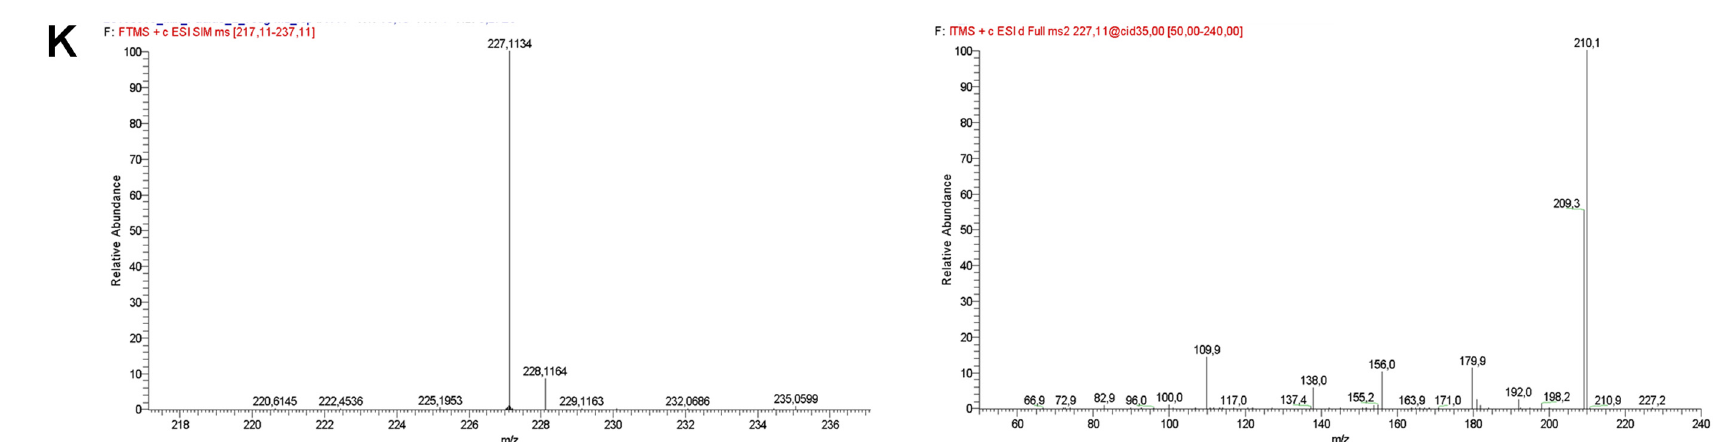
Figure 1. MS and MS 2 spectra of riboflavin ( A ), tryptophan ( B ), thiamine ( C ), histidine ( D ), anserine ( E ), nicotinamide ( F ), hypoxanthine ( G ), phenylalanine ( H ), isoleucine ( I ), taurine ( J ) and carnosine ( K ) in the mixed standard solution.